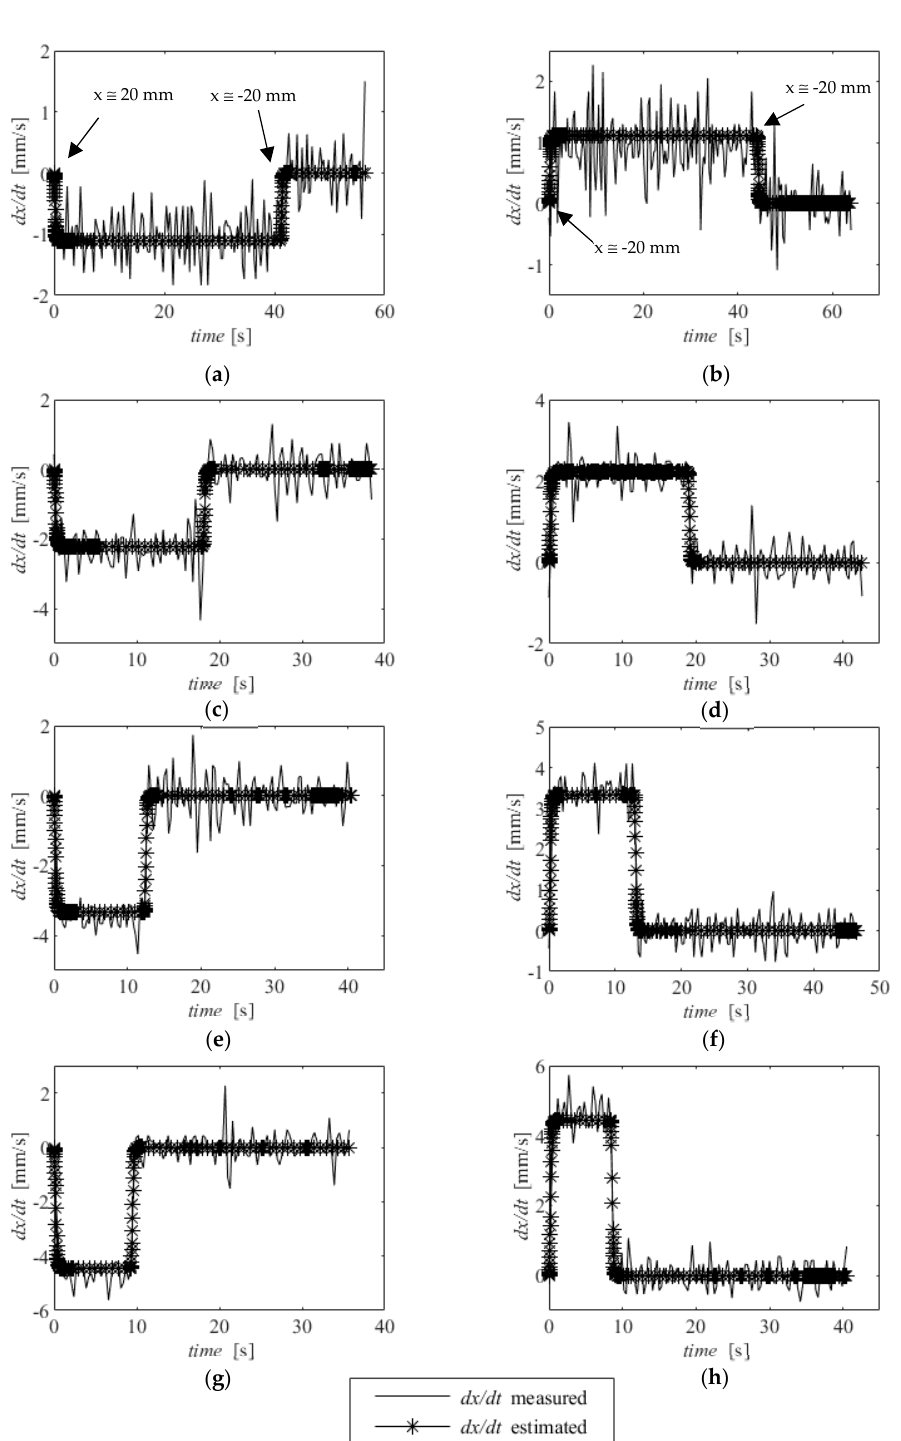
Figure 7. Identification results for experiments 1: ( a ) u = − 2.5 V, ( b ) u = 2.5 V, ( c ) u = − 5 V, ( d ) u = 5 V, ( e ) u = − 7.5 V, ( f ) u = 7.5 V, ( g ) u = − 10 V and ( h ), u = 10 V.